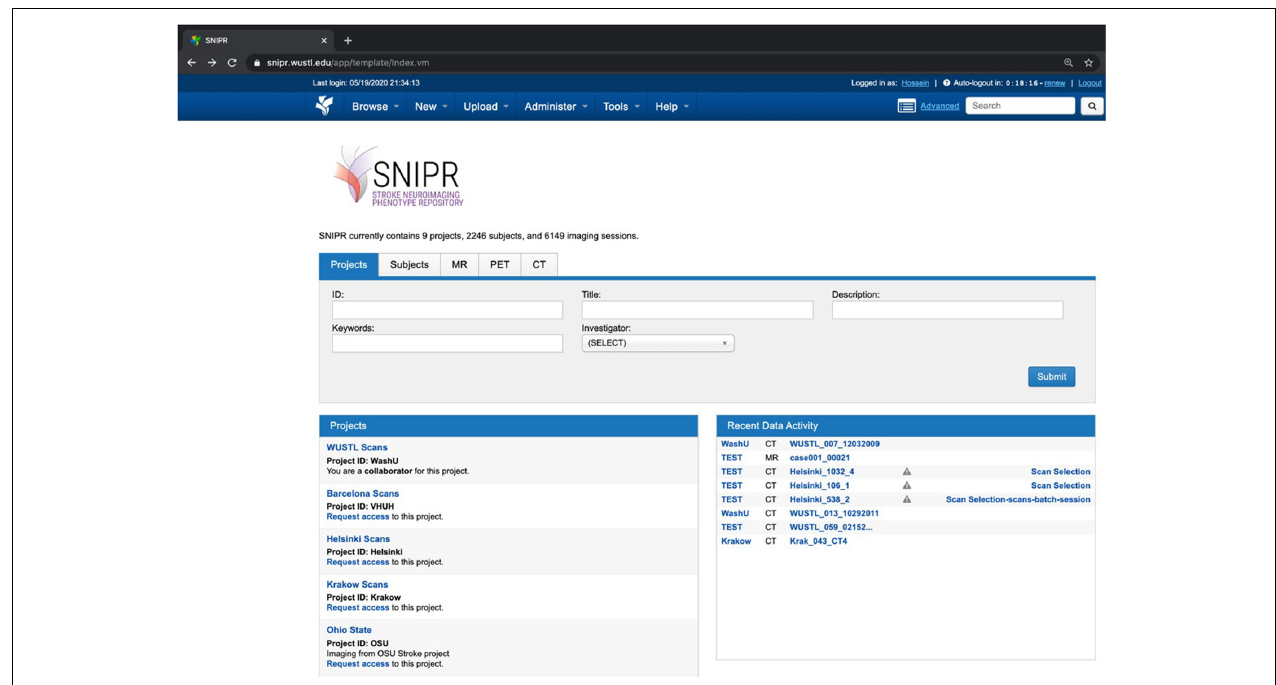
FIGURE 5 | SNIPR hosts eight study cohorts and 2,246 subjects now. SNIPR provides project owners with flexible control over access to their data. TABLE 3 | SNIPR now manages CT and MR data of 2,246 stroke patients with different disease types such as ischemic stroke, large vessel occlusion stroke, and subarachnoid hemorrhage. Disease Projects Access Number of Ischemic stroke Krakow, Barcelona, Helsinki, WashU, Private 1,947 4,577 CT, MR